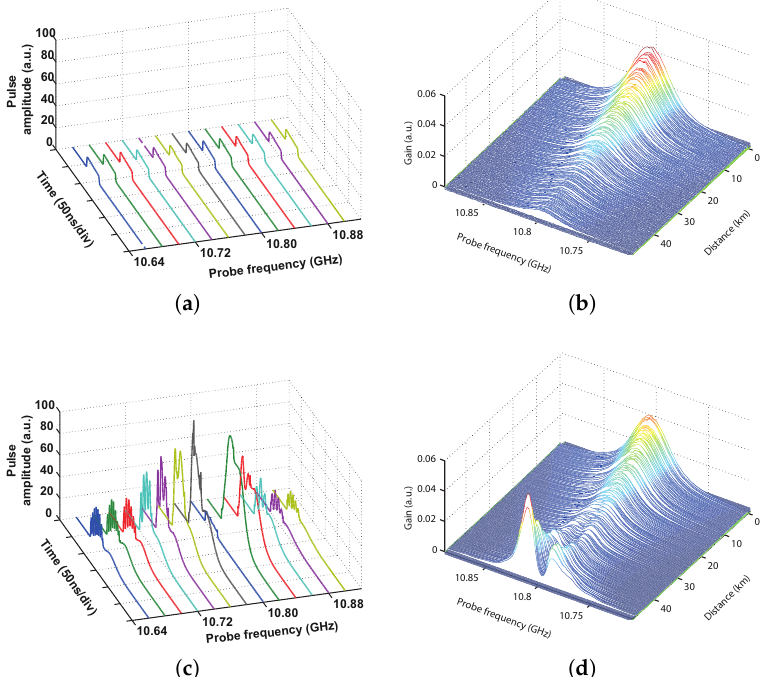
Figure 3. Pulses at the output of the fiber and measured Brillouin spectra for a conventional dual-probe BOTDA in two cases for probe wave powers of − 6 dBm ( a , b ) and 5 dBm ( c , d ). (From R. Ruiz-Lombera, J. Urricelqui, M. Sagues, J. Mirapeix, J. M. López-Higuera and A.